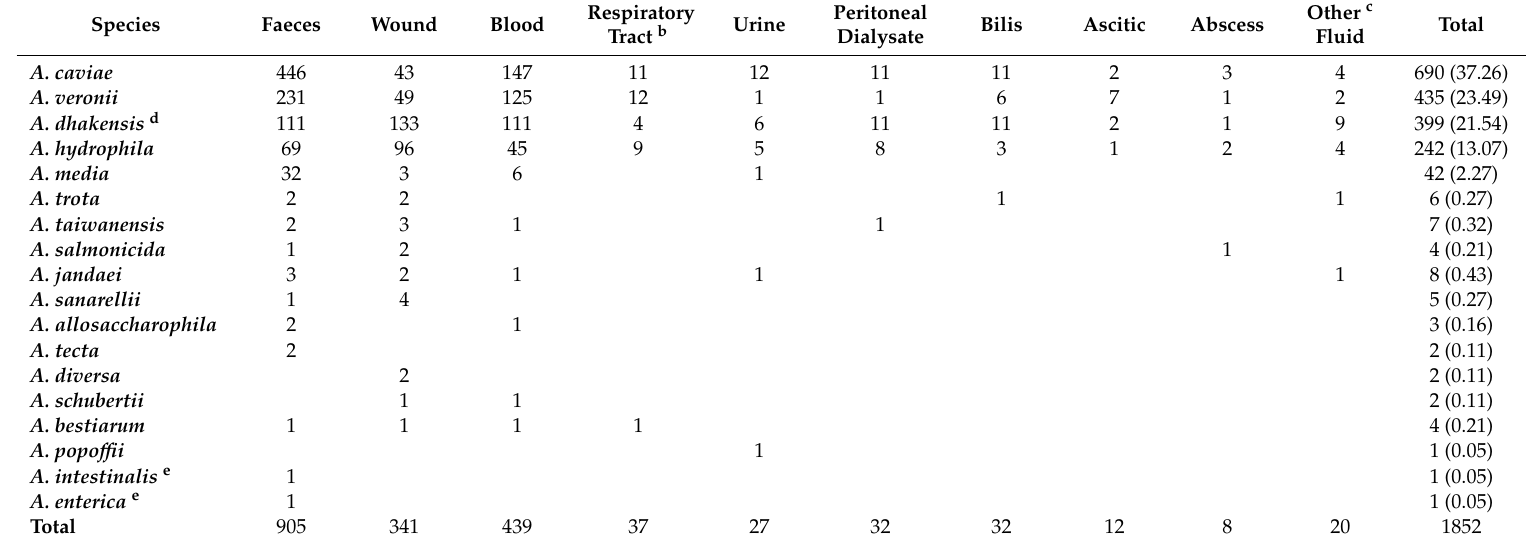
Table 1. Distribution of Aeromonas spp. identified with molecular methods and recovered from di ff erent sites in association with human infections a